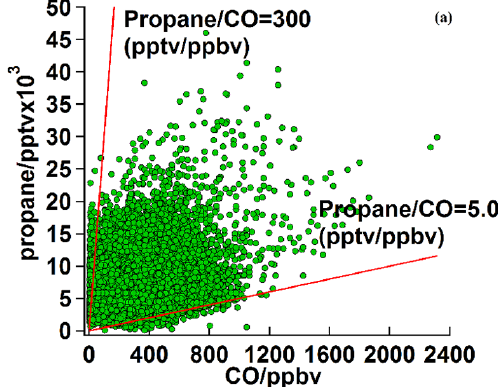
Figure 2. Hourly ratio of propane / CO at MK during 2011–2014.